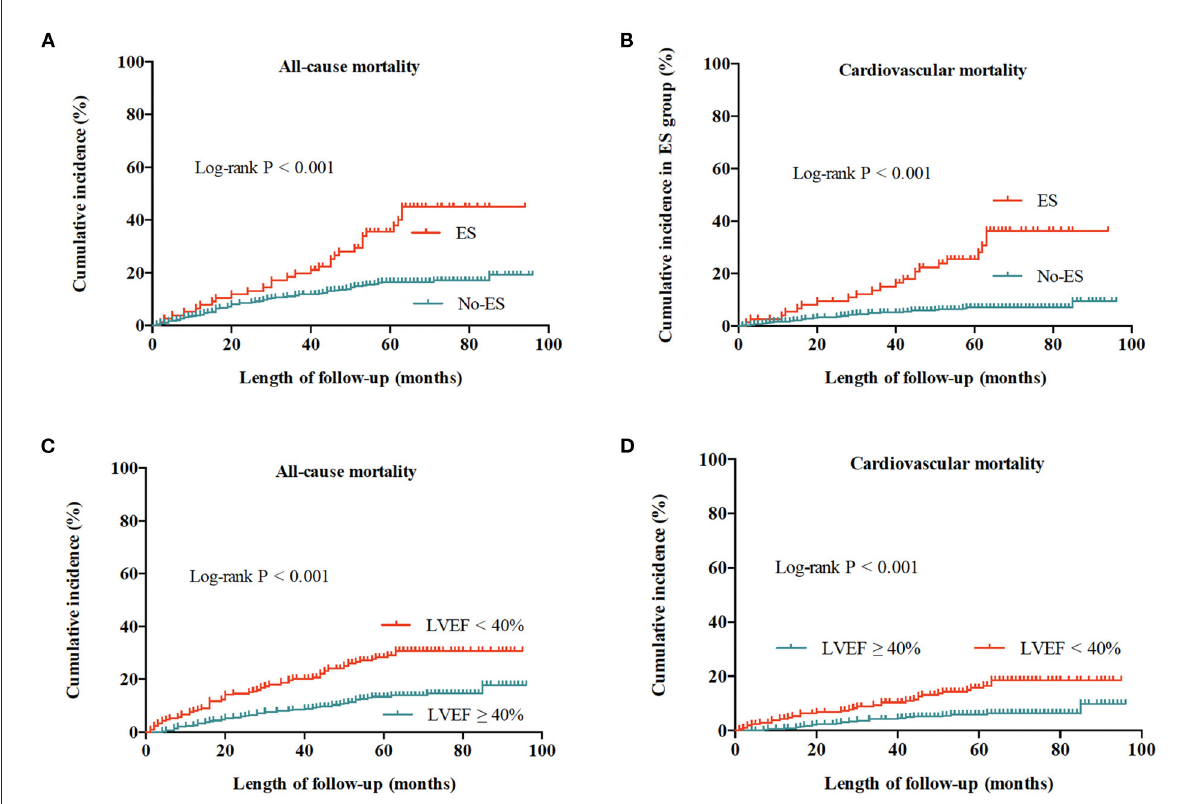
FIGURE1 Cumulative incidences of all-cause and cardiovascular mortality for the whole population. (A) All-cause mortality for patients with ES and without ES. (B) Cardiovascular mortality for patients with ES and without ES. (C) All-cause mortality for patients with preserved LVEF ( ≥ 40%) and impaired LVEF ( < 40%). (D) Cardiovascular mortality for patients with preserved LVEF ( ≥ 40%) and impaired LVEF ( <